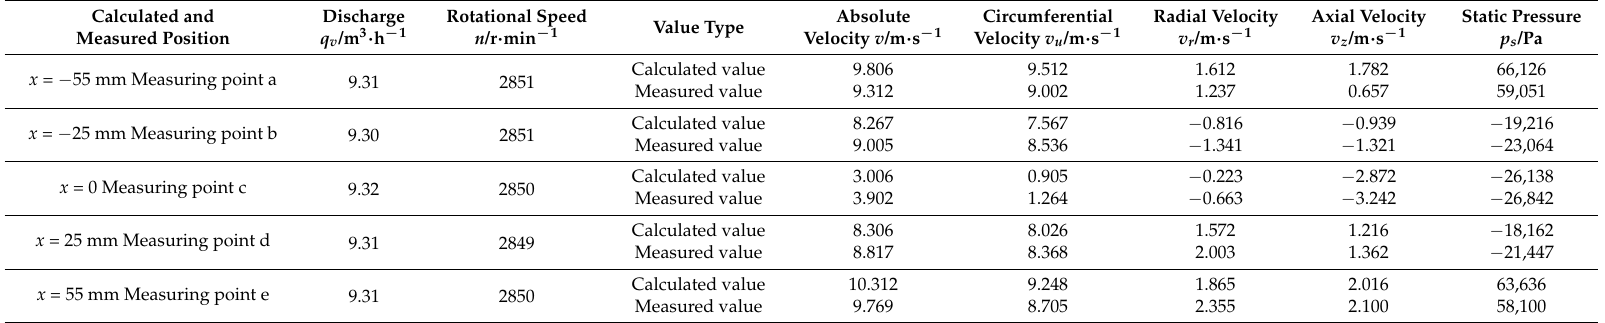
Table 3. Calculated and measured values of flow field curves on the axial cross-section Z = 12.5